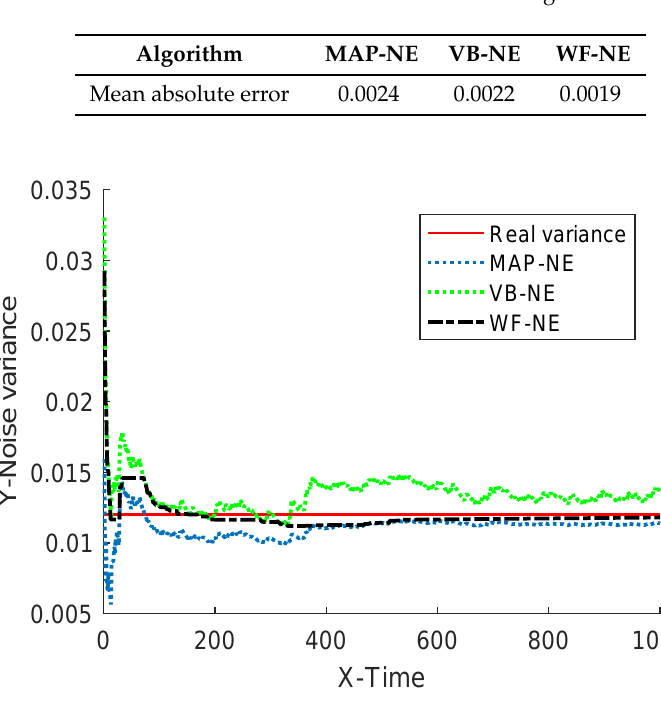
Table 2. The mean absolute error of three noise estimation algorithms in Situation 2.